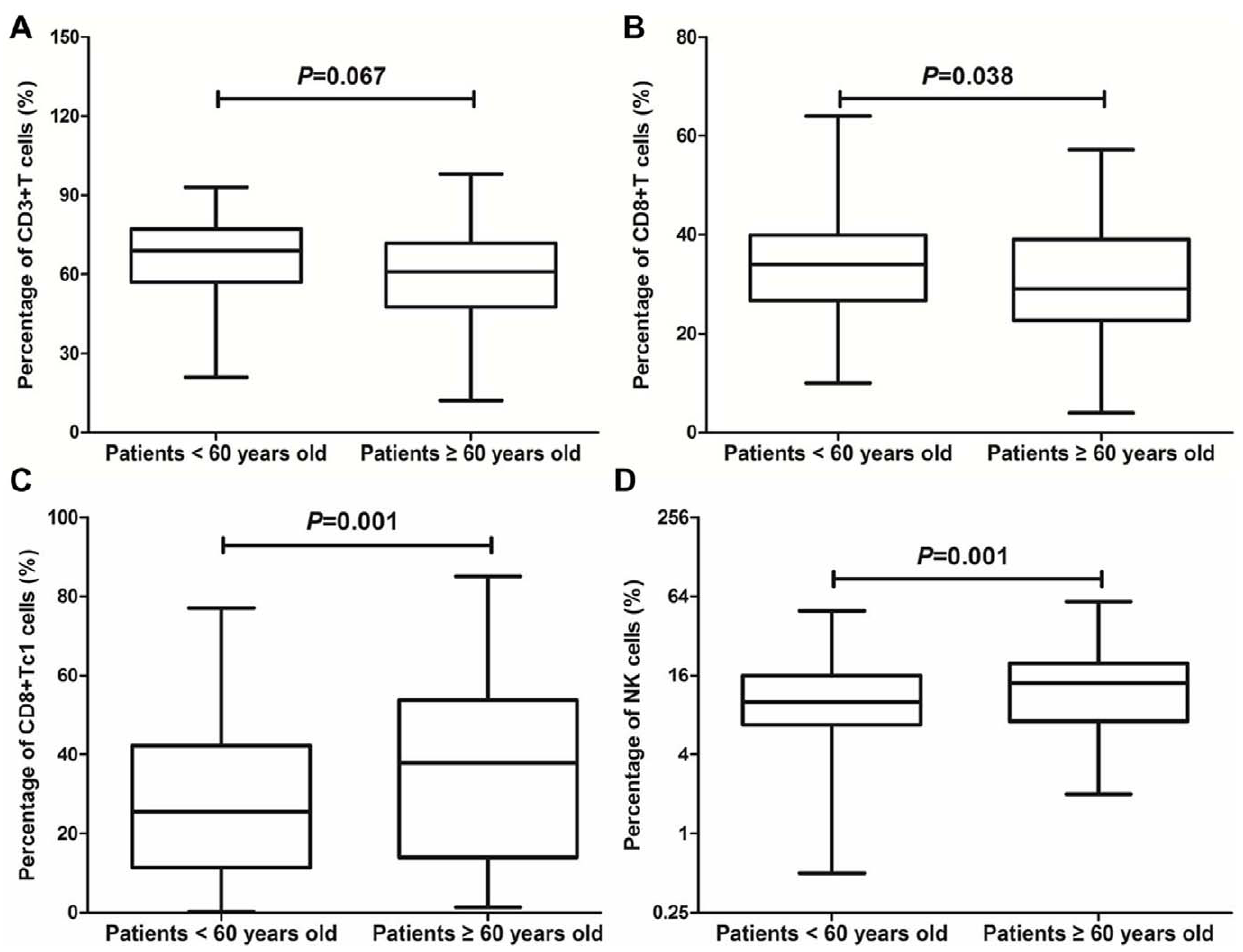
Figure 2. Comparison analysis in BM lymphocytes between the younger and older patients with MDS patients. Compared with the older patients with MDS, the younger ones showed higher percentage of total T cells (CD3 + cells) ( A ) and CD8 + T cells ( B ) ( P =0.067; P =0.038). However, the older patients showed higher percentage of CD8 + Tc1 cells (CD8 + IFN- c + cells) ( C ) and NK cells (CD16 + or 56 + cells) ( D ) than the younger ones ( P =0.001; P